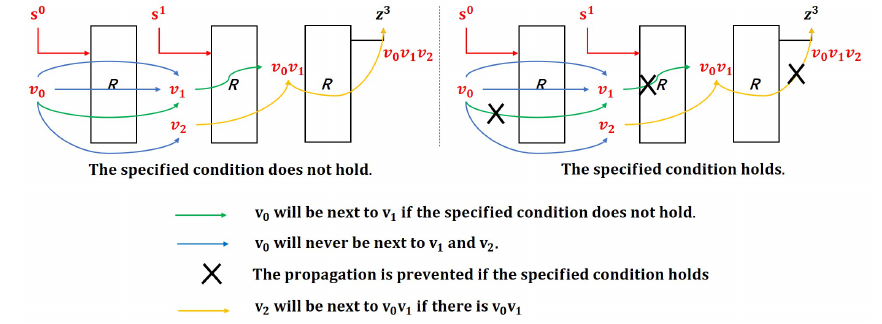
Figure 5: Illustration of TYPE-II conditional cube tester